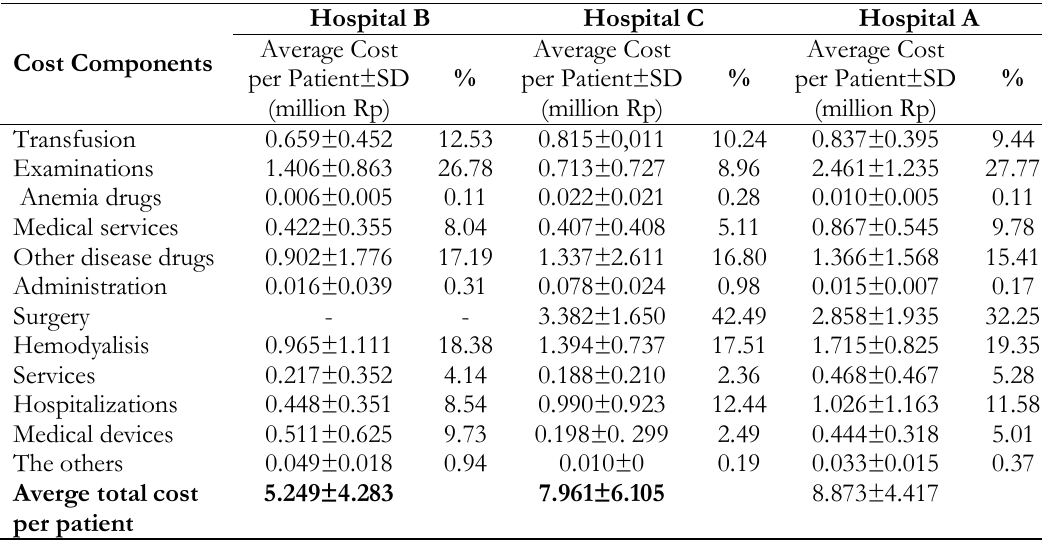
Table III. Cost components of anemia treatment in inpatients with CRF who received blood transfusion in A, B and C Hospitals in